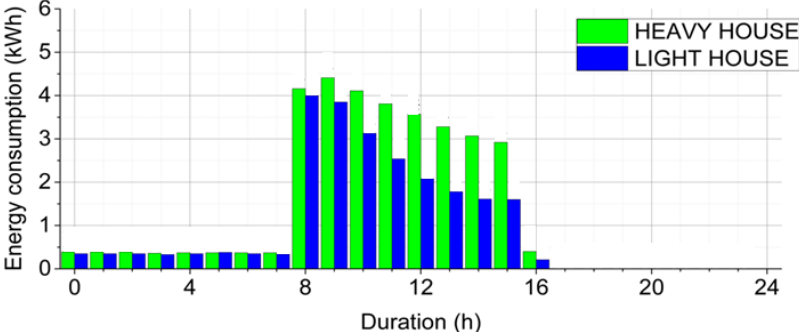
Figure 21. Energy consumption in the test chamber for both thermal